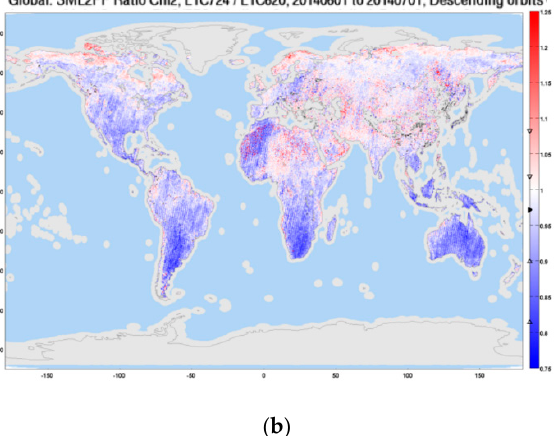
Figure 19. Maps of averaged difference, v724–v620, over the month of June 2014 in ( a ) soil moisture for ascending orbits, ( b ) soil moisture in descending orbits, ( c ) VOD in ascending orbits and ( d ) VOD in descending orbitsBlue (resp., red) indicates a decrease (resp., an increase) in V724 soil moisture, VOD compared to v620.